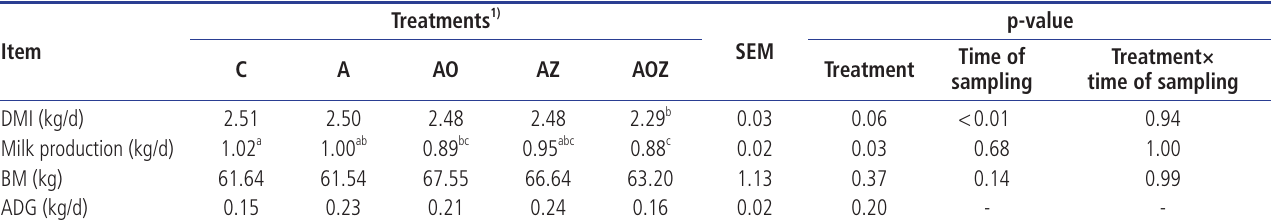
Table 2. Effects of aflatoxin B1 (AFB1), ochratoxin A (OTA), and zearalenone (ZEA) on DMI, milk production, and body mass of dairy goats